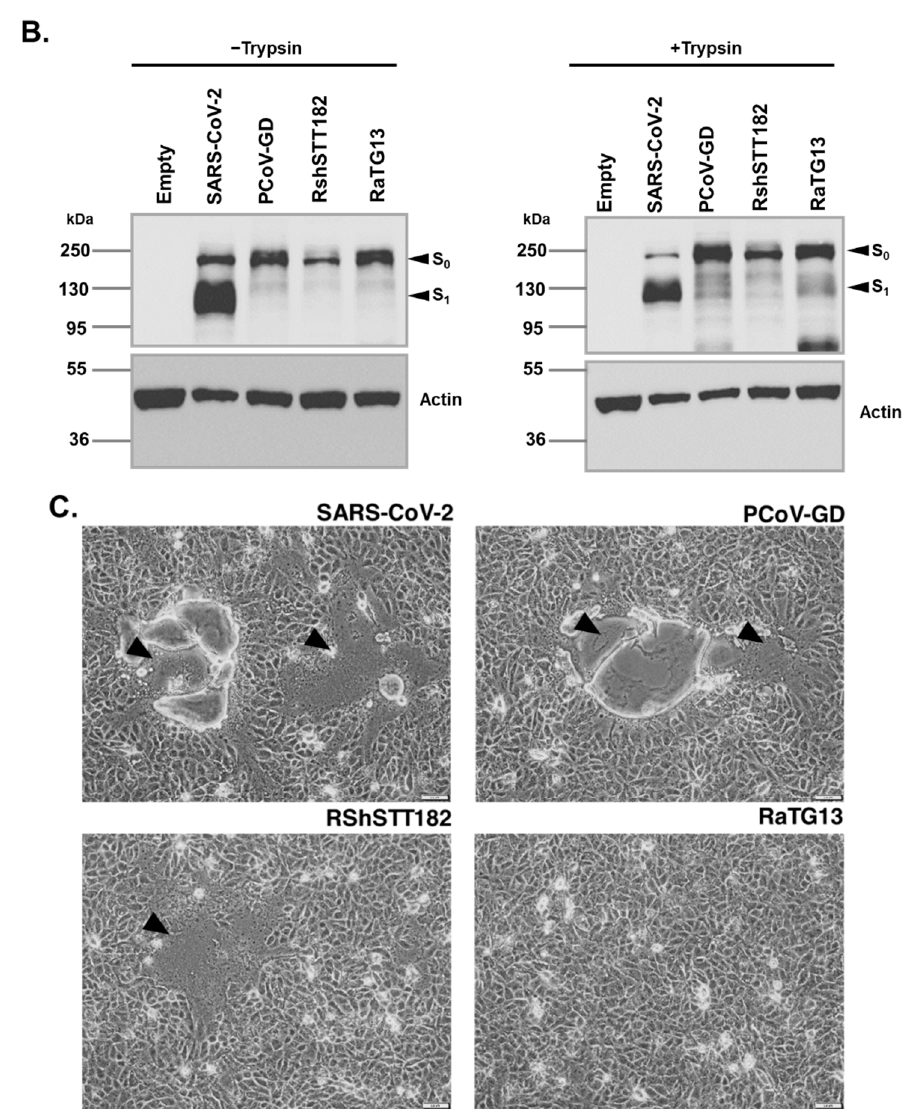
Figure 1. Expression and cell-cell fusion activity of sarbecovirus spikes in VeroE6 cells. ( A ). The sequence alignment of the RBD of SARS-CoV-2 and that of PCoV-GD, RShSTT182, and RaTG13. Black triangles indicate interacting amino acids of the RBD of SARS-CoV-2 with hACE2. Alignment was performed using QIAGEN CLC Genomics Workbench and percent similarity was analyzed using the web-based platform SIAS (Universidad Complutense de Madrid). ( B ). Expression of each spike variant in HEK-293T cells in the absence and presence of trypsin. The unprocessed spike (S0) and the cleaved spike product (S1) are indicated by arrows. Expression of beta-actin served as a loading control. ( C ). Cell–cell fusion in VeroE6 cells transfected with each spike variant in the presence of trypsin. Images were taken under an inverted light microscope 24 h after transfection (100- µ m scale bars). Black arrows mark representative areas where cell–cell fusion was